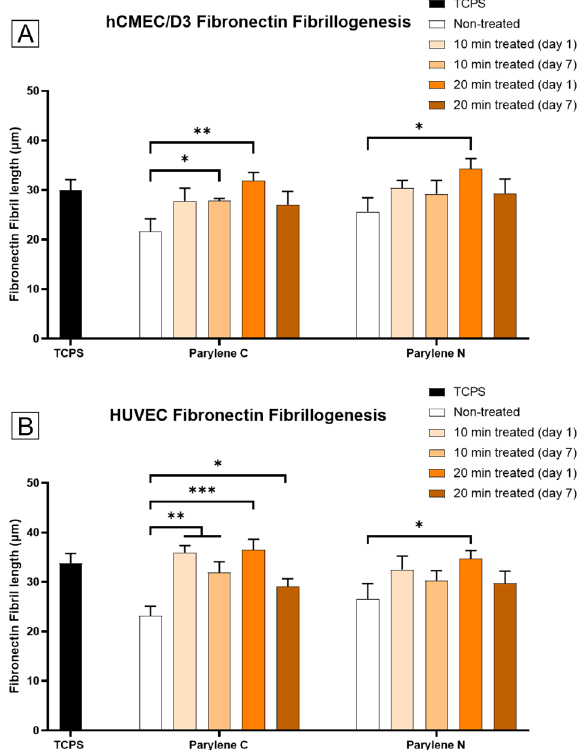
Figure 4. Changes in fibronectin fibrillogenesis by vascular endothelial cells on Parylene C and Parylene N membranes result from plasma treatment. ( A ) hCMEC/D3 fibronectin fibril lengths on TPCS, Parylene C, and Parylene N membranes. ( B ) HUVEC fibronectin fibril lengths on TCPS, Parylene C, and Parylene N